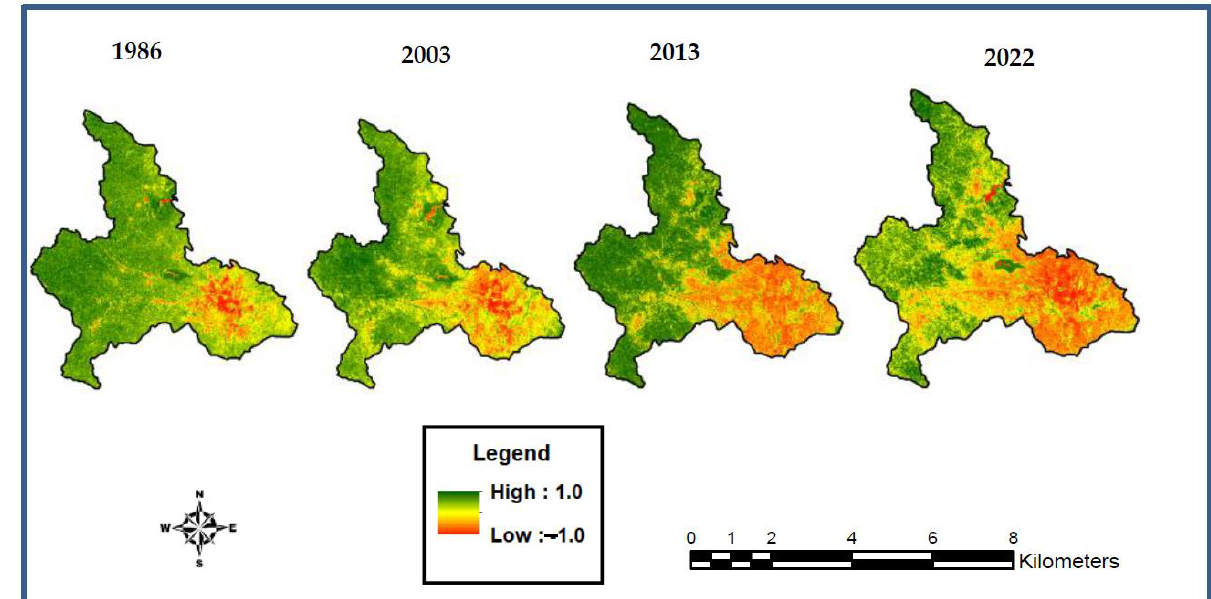
Figure 7. NDVI maps of the study area.